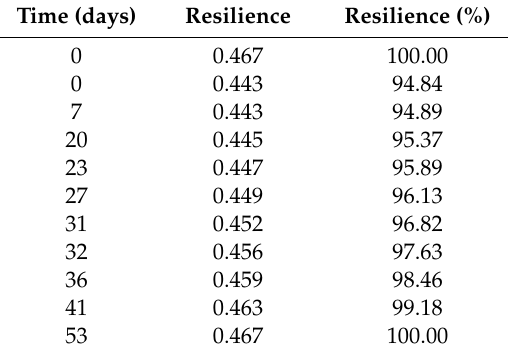
Table 10. Resilience computations for strategy 1.